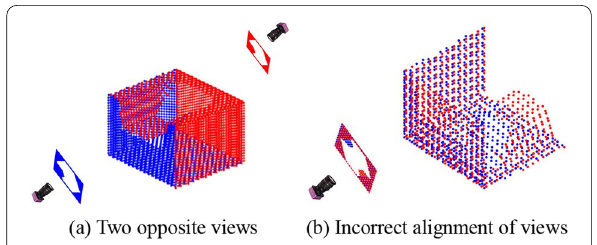
Figure 5 Two different view